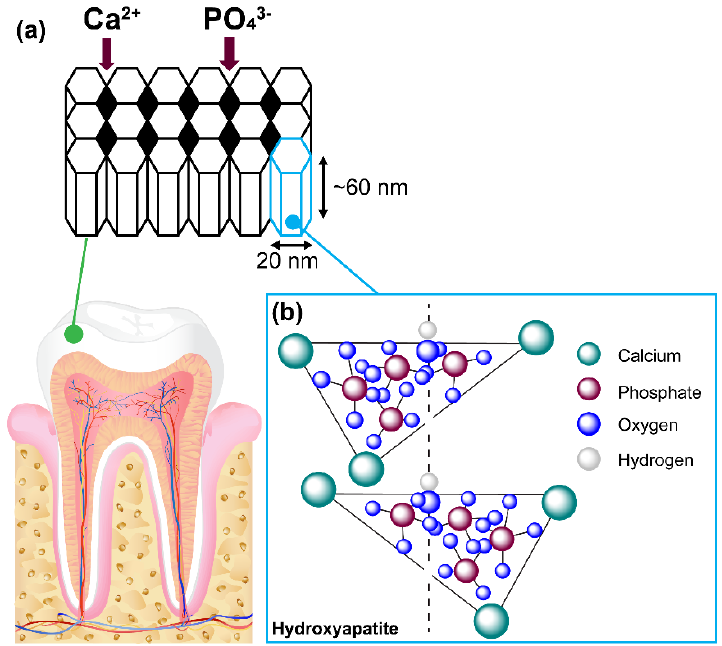
Figure 1. Schematic representation of enamel microstructure. (a) Arrangement of the hydroxyapatite crystals, the cavities shown by the black diamond shape, allows Ca 2+ and PO 43 − ions from saliva to crystals, the cavities shown by the black diamond shape, allows Ca 2 + and PO 43 − ions from saliva to pass through and assist in remineralization. (b) Molecular arrangement of individual unit cells pass through and assist in remineralization. ( b ) Molecular arrangement of individual unit cells making making up the hydroxyapatite. up the